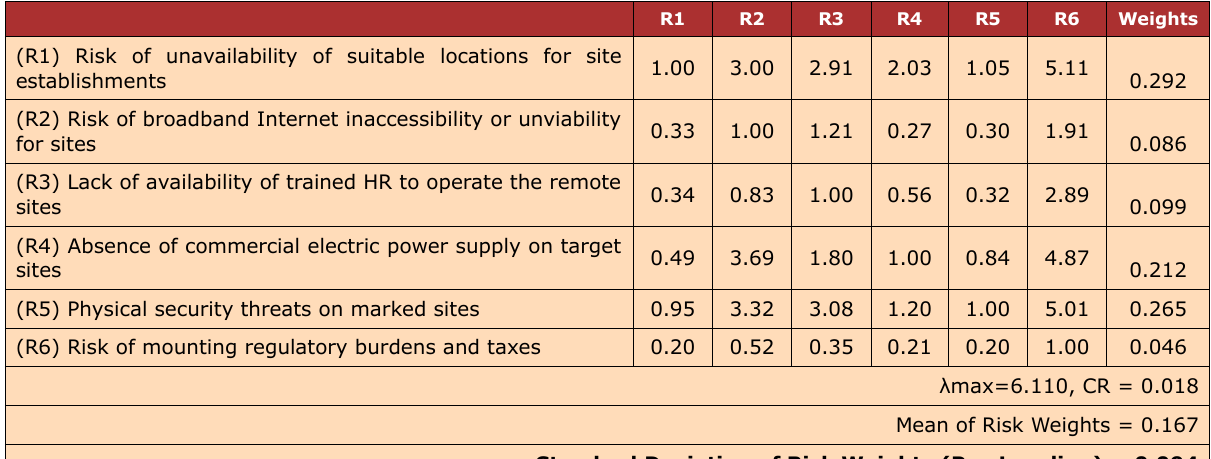
Table 1. Tele-Centres Program Risks – Pre-Leveling Comparison Matrix & Relative Weights